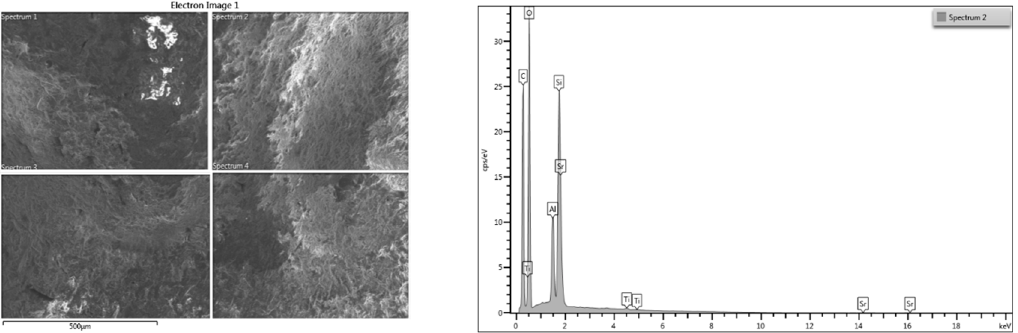
Figure 4. EDX analysis for the newly obtained 3D-printed nanocomposite (denture).